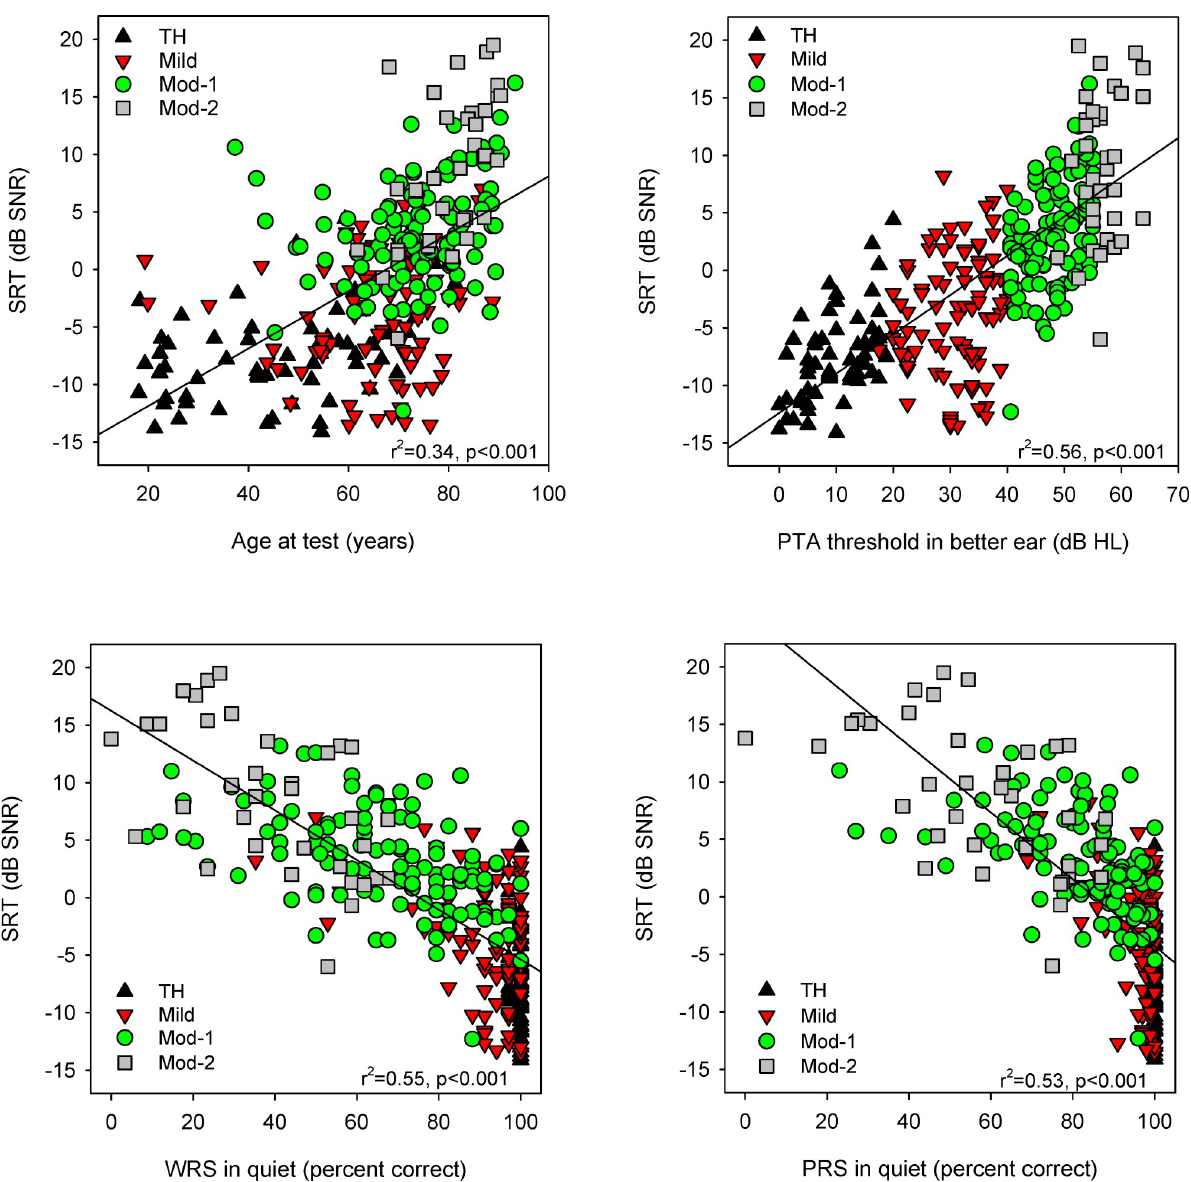
Fig 3. Scatterplots of SRTs in diffuse noise. SRTs are shown as a function of (clockwise from top left): age at testing, pure-tone average (PTA) threshold in the better ear, phoneme recognition scores (PRS) in quiet, and word recognition scores (WRS) in quiet. In each panel, the different symbols show data for the different hearing groups. The diagonal lines show linear regression fits to all data in the plot; r and p values are shown in the lower right of each panel.